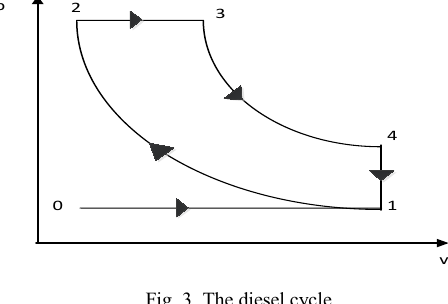
Fig. 3. The diesel